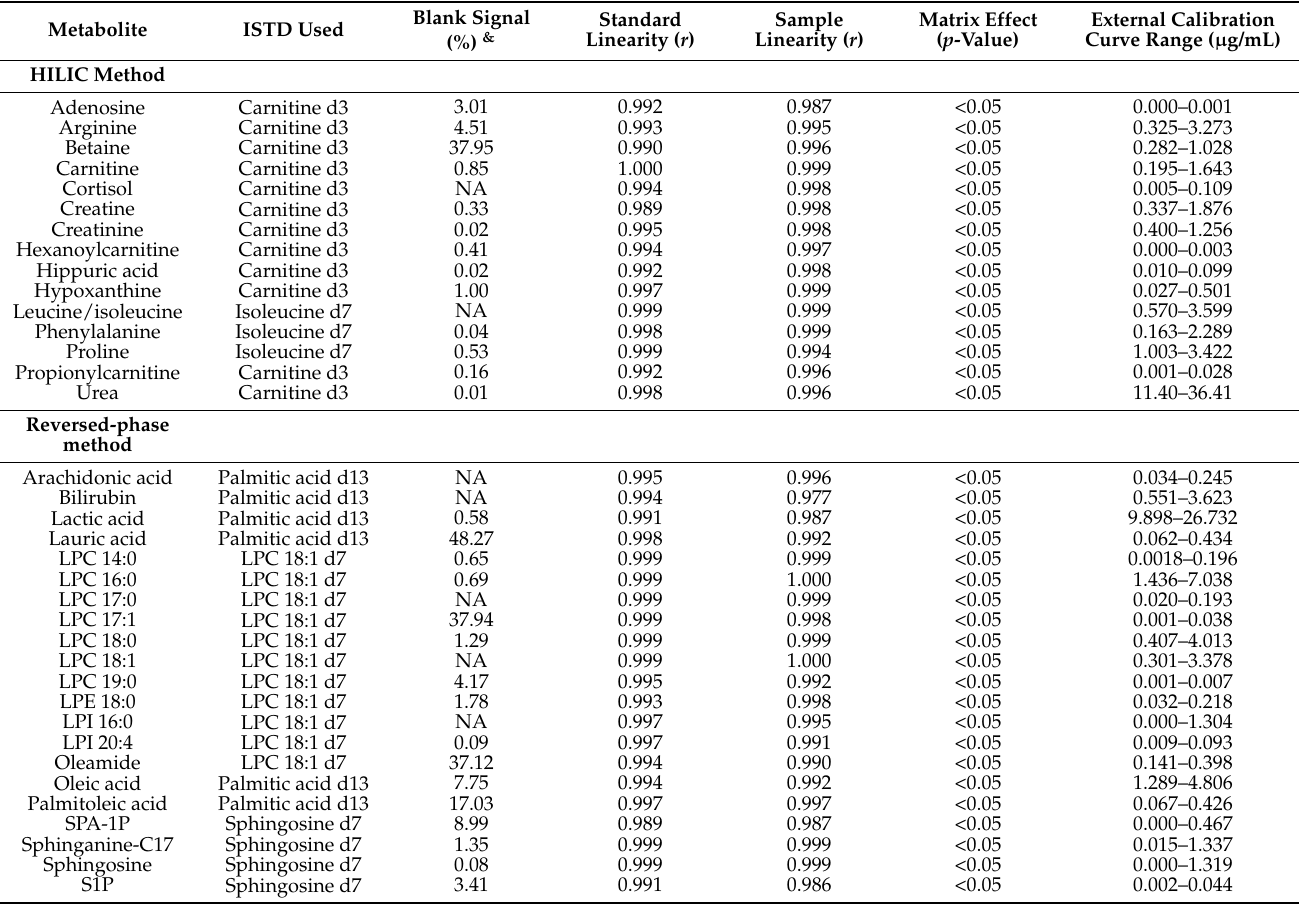
Table 2. Validation parameters for HILIC and reversed-phase